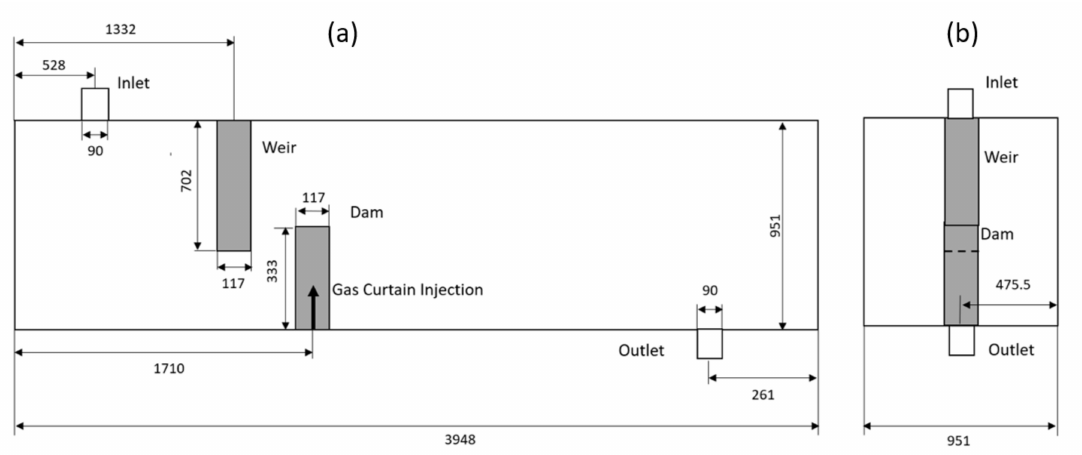
Figure 1. Dimensions of single-strand tundish (unit: mm): ( a ) Frontal View; ( b ) Lateral